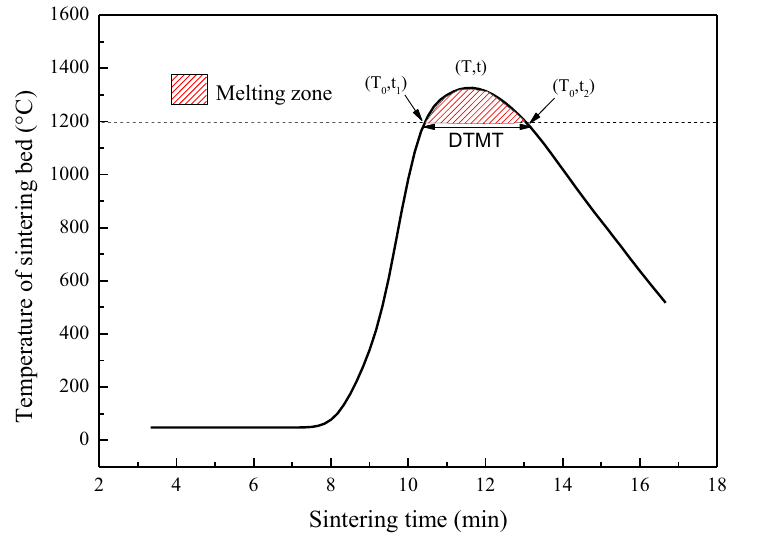
Figure 2. DTMT and melting zone of the sintering bed temperature